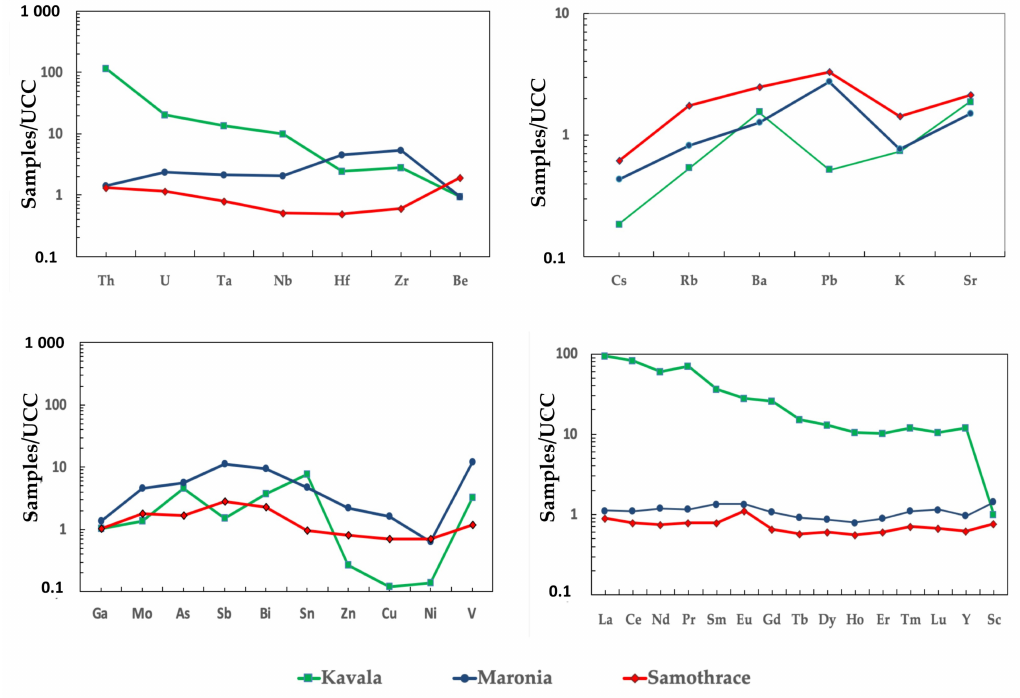
Figure 5. UCC-normalized compositional spidergrams for REE, HFSE, LILE, and transition metals of coastal sand deposits representing di ff erent localities of Northern